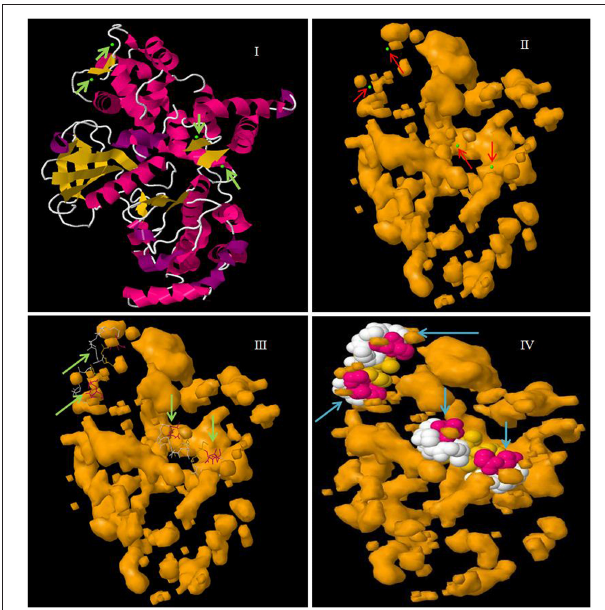
FIGURE 4 | Molecular structure of CPK protein showing four EF-hand domains. In the figure, (I) represents the secondary structure of CPK protein with calcium binding sites in green, (II) the cavity surface of CPK protein with calcium binding sites shown in green, (III) the Ca 2 + ligand interaction with CPK protein, and (IV) a space fill view of the Ca 2 + ligand interaction in cavity model of CPK protein. The molecular model was constructed in the Geno3D server using protein sequence of AtCPK1 as the query search.